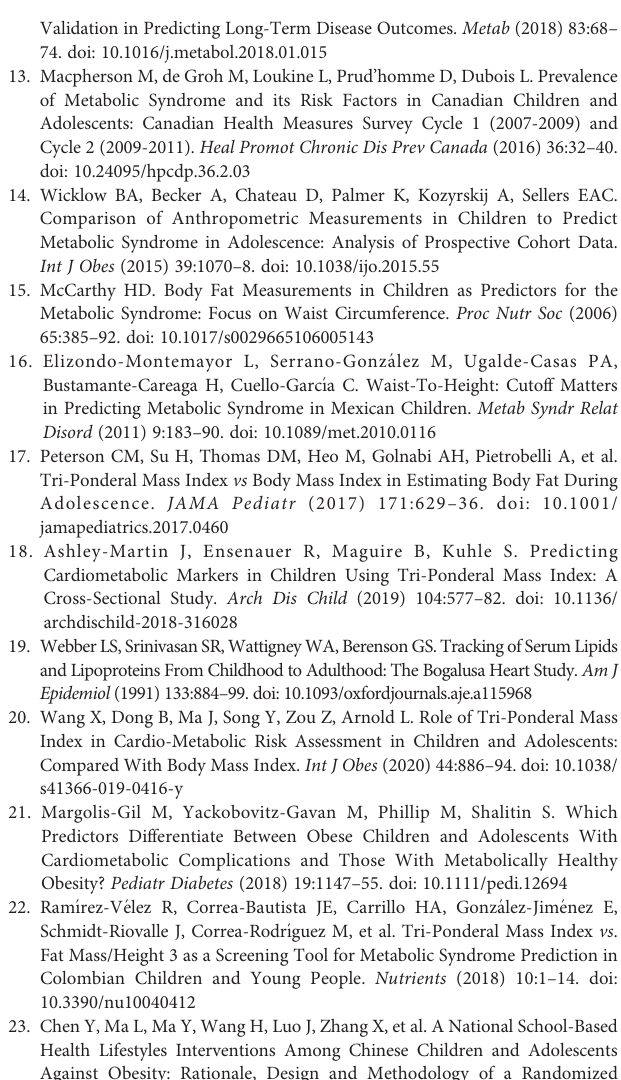
children, and from Anthropometric reference data for children and adults: United States, 2011-2014 for American children. Supplementary Table 2 | Parameters of the receiver operating characteristic (ROC) curves analysis for the diagnostic performance of Tri-ponderal Mass (TMI) in identifying cardiometabolic risks in Chinese and American children. TG, triglycerides; HDL-C, high density lipoprotein cholesterol; CI, con fi dential interval; PV (+), positive predictive value; PV (-), negative predictive value. Supplementary Table 3 | Tri-ponderal mass index threshold for the optimal cut- off percentiles. Supplementary Table 4 | Sensitivity analysis of different subgroups in Chinese validate population. FPR, false positive rate; FNR, false negative rate; TR, total misclassi fi cation rate. * Area under curve decreased signi fi cantly compared to the former cut off percentile. Sex speci fi c 75 th , 80 th and 85 th percentiles were used as threshold values for each population. Supplementary Table 5 | Sensitivity analysis of different subgroups in American validate